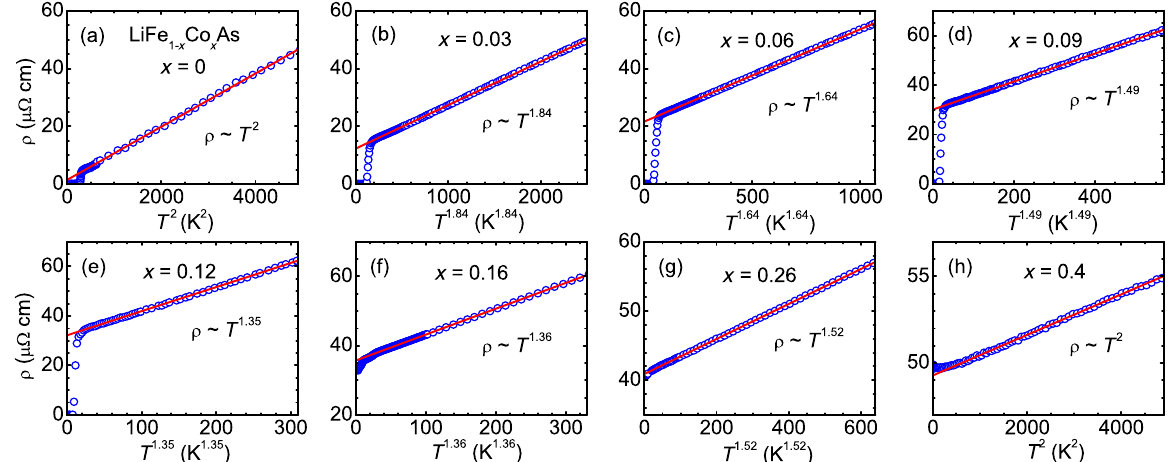
FIG. 6. (a) – (h) Resistivity of LiFe 1 − x Co x As as a function of T n for different Co values. n is the power determined from the single power-law fit to the resistivity as a function of T . The straight solid line in each panel is a guide to the